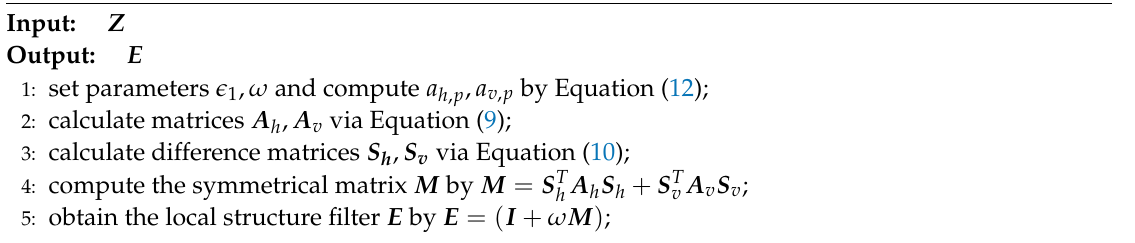
Algorithm 1 The calculation of the local structure filter